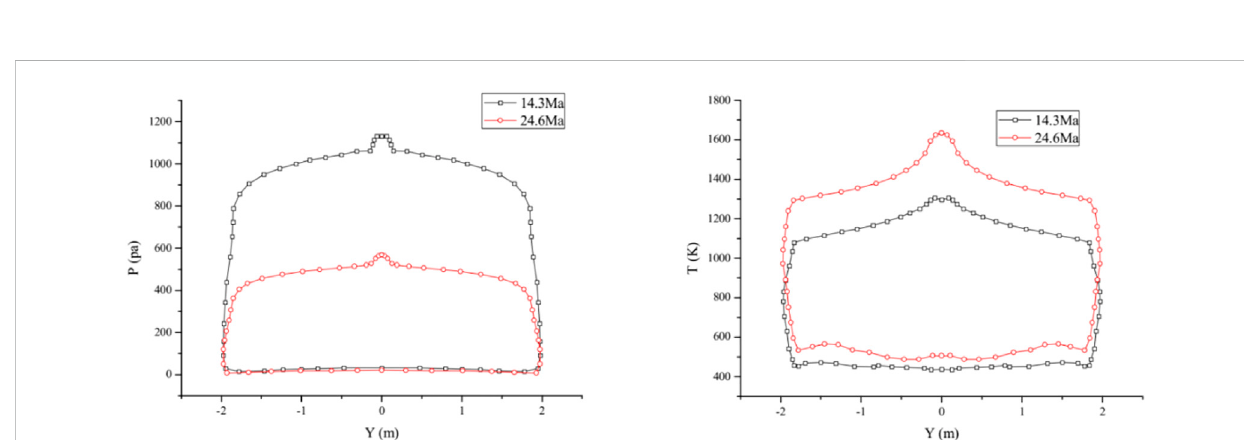
performed under extreme thermal loads (82 km – Ma24.6) based on the LS-DYNA multi-physical fi eld coupling analysis platform. Figures 12, 13 show the normalized strain-stress distribution curves of the meridian coordinates of each functional layer under the fl ight condition of Ma24.6. It can be seen that the stress concentration occurred in the contact position between the TPS